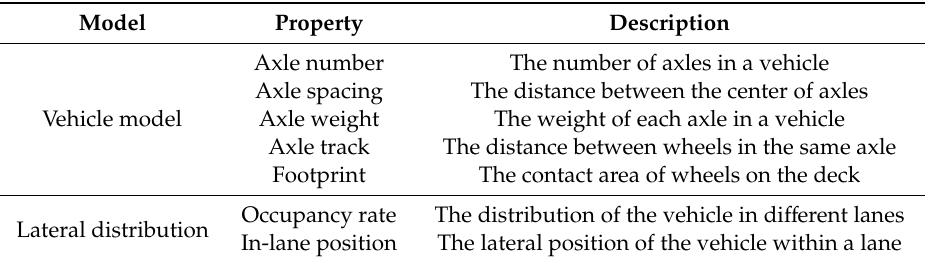
Table 4. Illustration of the stochastic traffic model [27].